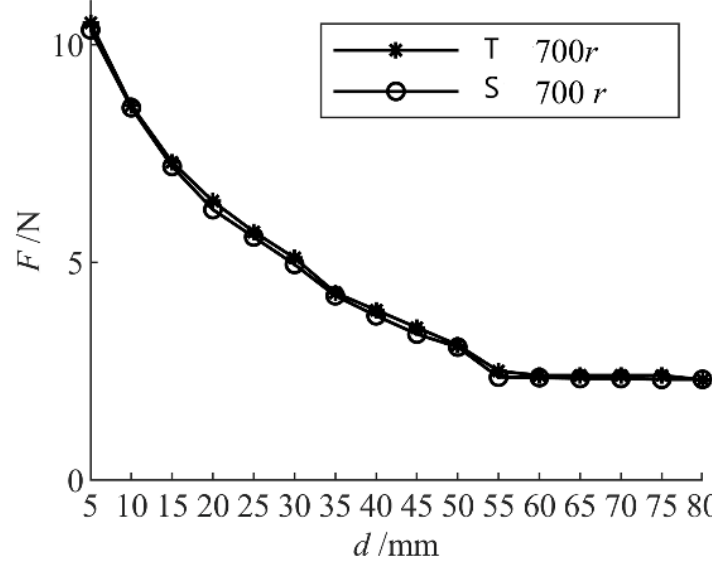
Figure 23. F- d ( v = 700 r/min, δ = 0.2).